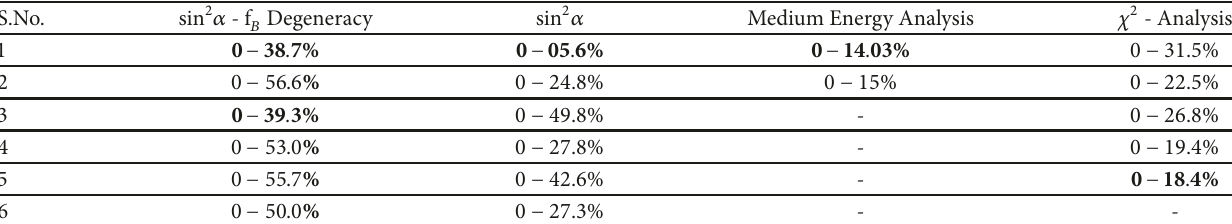
Table 10: Sterile neutrino percentage obtained from various model independent ways.